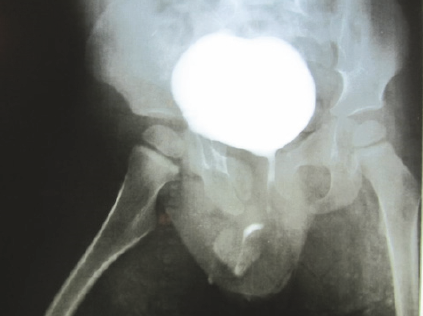
Figure 3: VCUG six weeks after urethral repair surgery showing normal bladder and